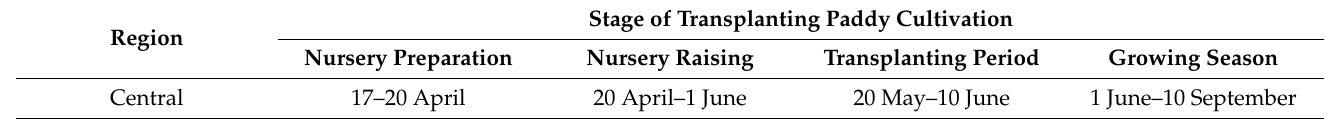
Table 1. Standard rice cropping period in Korea [38].